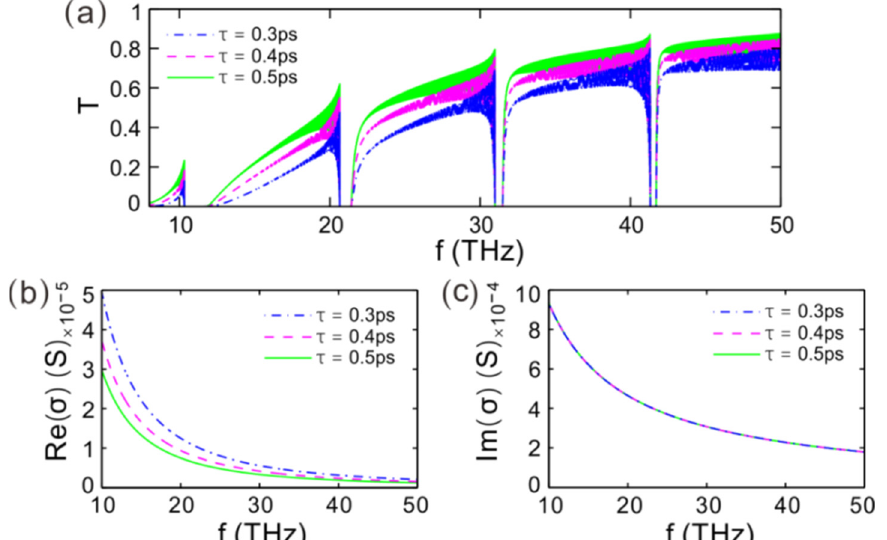
Figure 6. ( a ) Dependence of the transmission spectra on the phenomenological relaxation time τ . ( b , c ) Real part and imaginary part of graphene surface conductivity varying with τ , respectively. The graphene chemical potential is set as μ = 0.4 eV for ( a – c ).